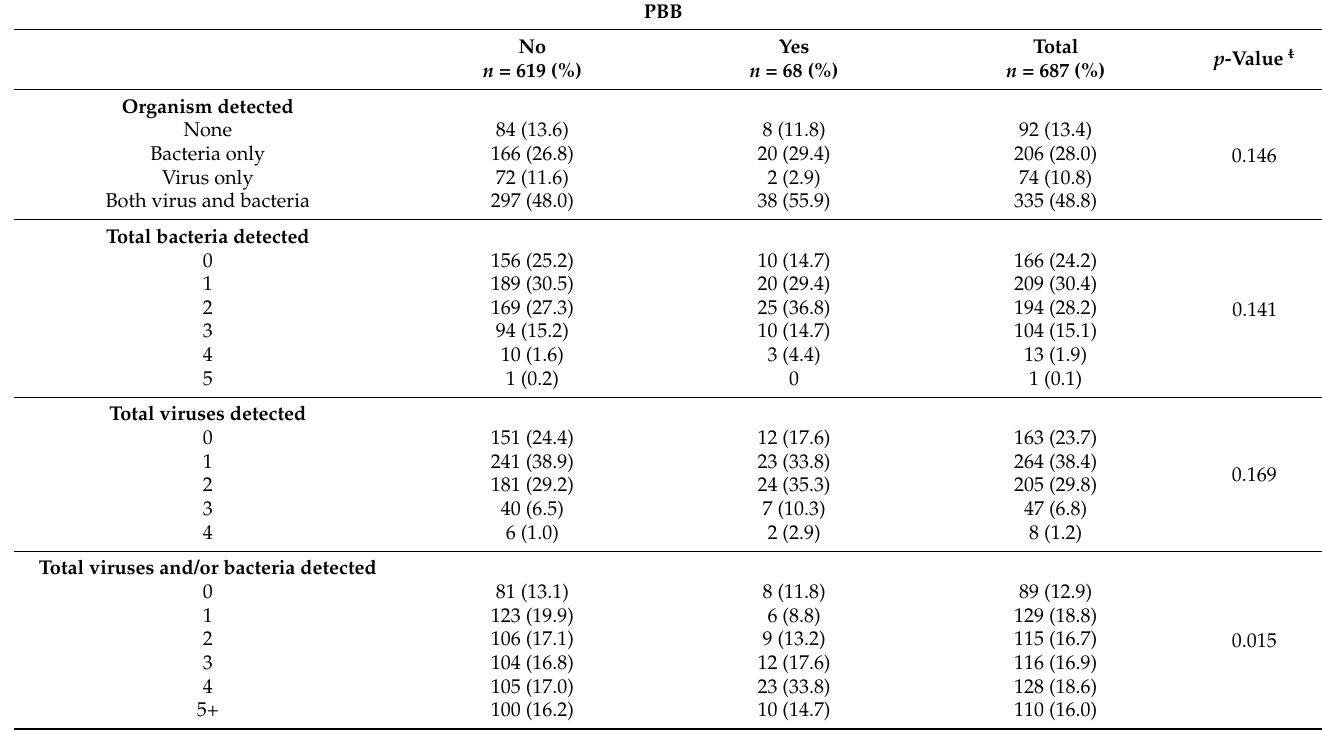
Table 3. Baseline microbiology ( n = 687